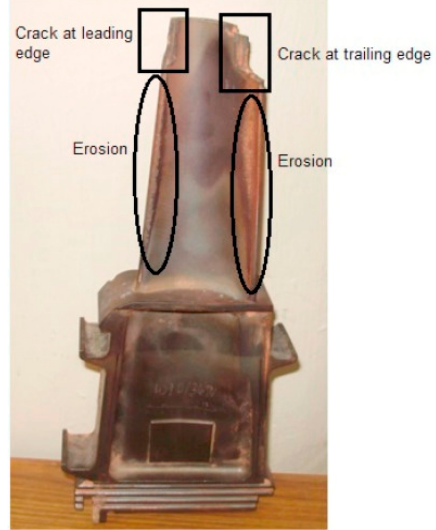
Figure 8. A damaged tip